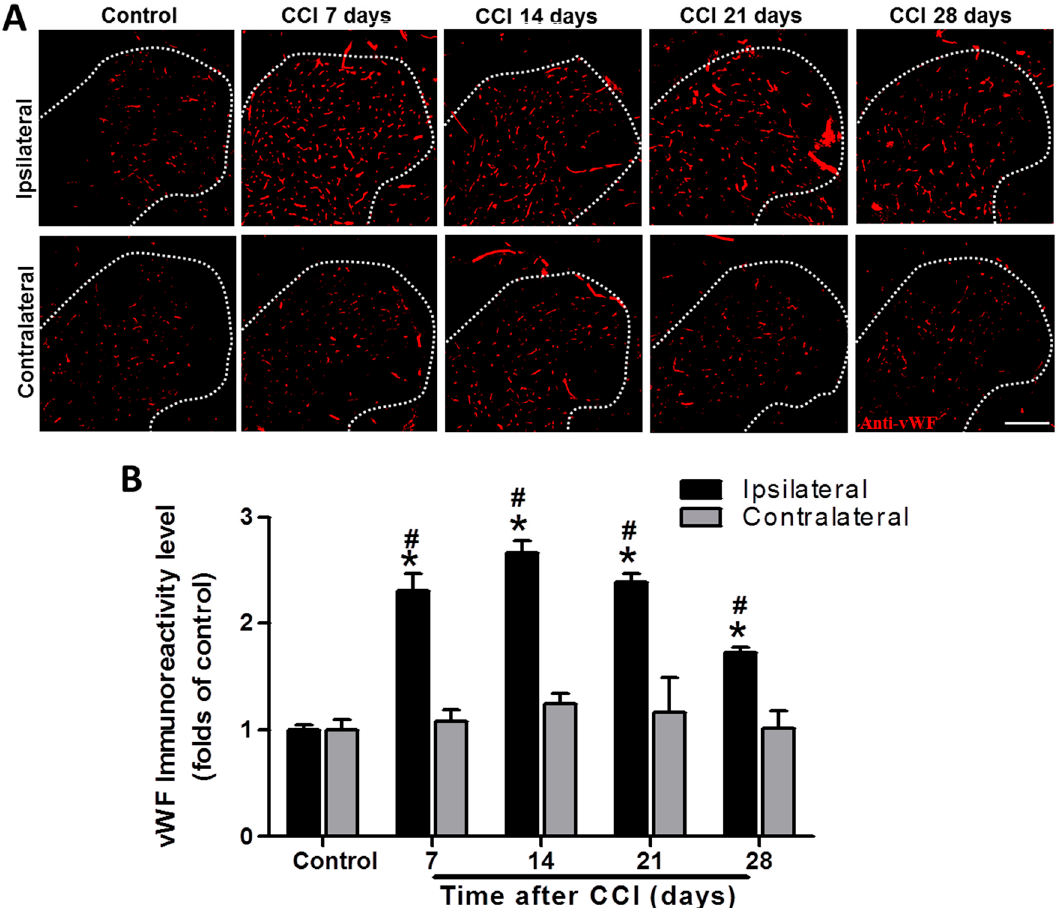
Figure 3. Representative von Willebrand factor (vWF) immunostaining in the rat lumbar spinal cord dorsal horn (SCDH) over a 28 − day period of chronic constriction injury (CCI) − induced neuropathic pain. ( A ) Representative vWF immunoflu- orescence (red) in the ipsilateral SCDH of control rats and CCI rats at post − operative day (POD) 7, 14, 21, and 28 (20 − µm sections; magnification: 100×; scale bars: 300 µm). ( B ) Quantification of immunofluorescence reactivity in the contralateral and ipsilateral SCDHs (4 sections per rat, three rats per group and each time point); values are expressed as means ± standard error of means (SEMs). *, p < 0.05 relative to the same side of controls; #, p < 0.05 relative to the contralateral side of the same group at the same time point, one-way analysis of variance (ANOVA) with post hoc Tukey test.